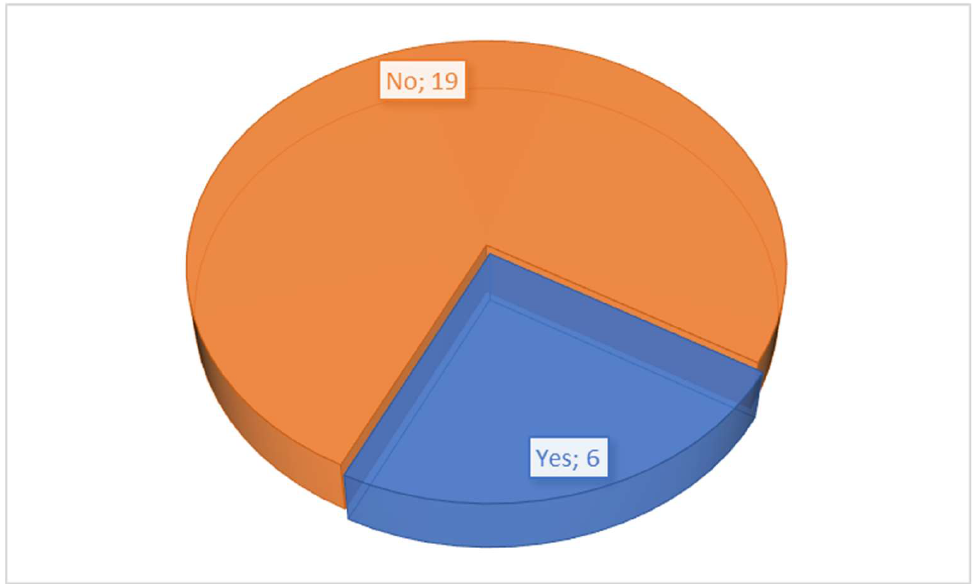
Figure 12. Public–private partnership in shared mobility systems. Despite the lack of cooperation with the socio-economic environment and competi- tion, the results indicate that 96% of respondents would like to be involved in the open innovations of their competitors. Detailed results are presented in Figure 13.